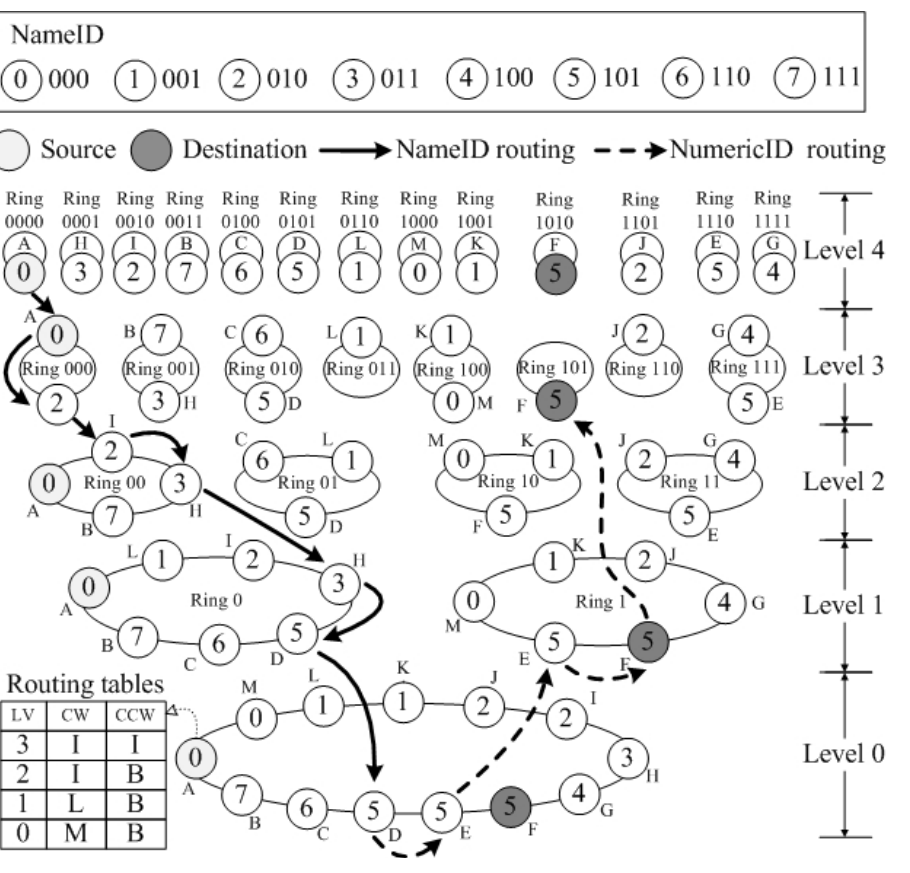
Figure 4. Topology and message routing of SkipNet-OCRS. LV, CW and CCW represent “level”, “clockwise neighbour” and “counterclockwise neighbour”